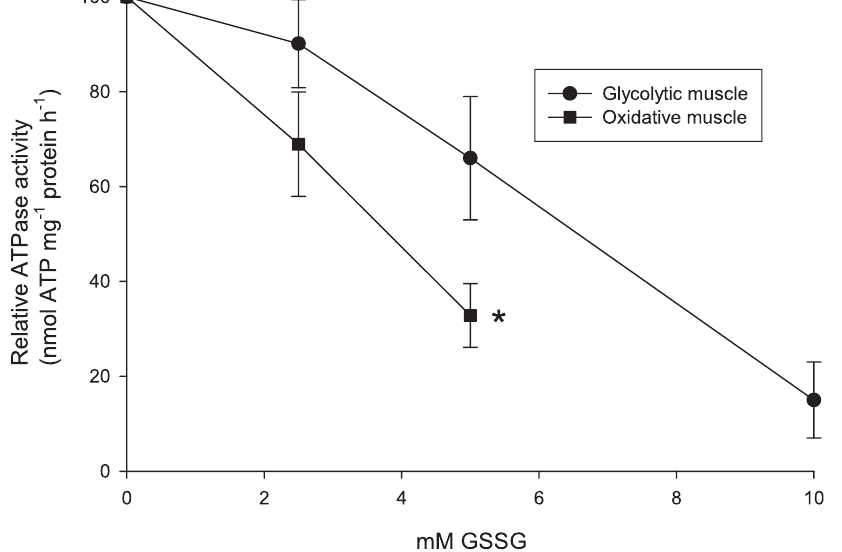
Figure 4. Effect of pre-treatment with oxidized glutathione (GSSG) on Na,K-ATPase activity in purified membranes from oxidative and glycolytic muscle. The Na,K-ATPase activity was evaluated by the difference in ATPase activity at 0 and 40 mM Na + . Values are calculated relative to control. Muscles from 6 rats. Squares: oxidative muscle, round symbol: glycolytic muscle *: Na,K-ATPase activity with 5 mM GSSG was significantly lower in oxidative muscle compared to glycolytic muscle (P , 0.05). Na,K-ATPase activity with 2.5 mM GSSG tended to be lower in oxidative compared to glycolytic muscle (P , 0.1).